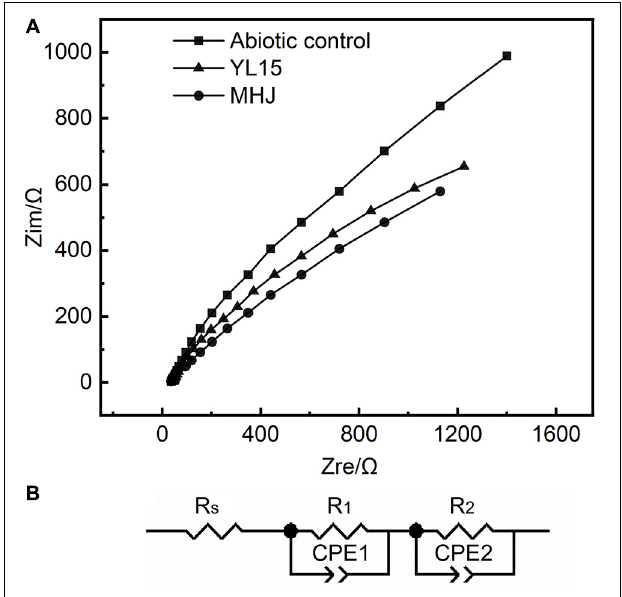
FIGURE 7 | Results of EIS. (A) EIS curves of chalcopyrite electrodes in different systems. (B) Simulated circuit R S (R 1 CPE1) (R 2 CPE2).